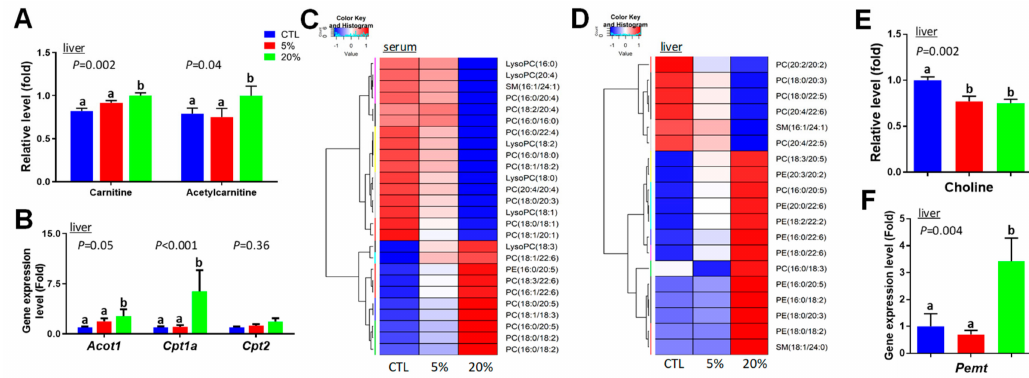
Figure 6. Identification of lipid metabolism-associated changes in serum and liver after Scenedesmus feeding. ( A )Hepaticcarnitine-relatedmetabolites. ( B )HepaticgeneexpressionlevelsofPPAR α -targeted genes. The control is artificially set as 1. ( C ) Hierarchal cluster analysis (HCA)-based heat map on the clustering of Scenedesmus -responsive phospholipids (PL) in serum based on their relative abundances. ( D ) HCA-based heat map on the clustering of Scenedesmus -responsive PL in the liver based on their relative abundances. ( E ) Choline in the liver. F . Expression level of Pemt gene in the liver. P -values indicate overall significances across all sample groups from the one-way ANOVA test. Means with di ff erent letter labels (a,b) indicate significant di ff erences ( P < 0.05) between two dietary treatments by the Tukey post hoc